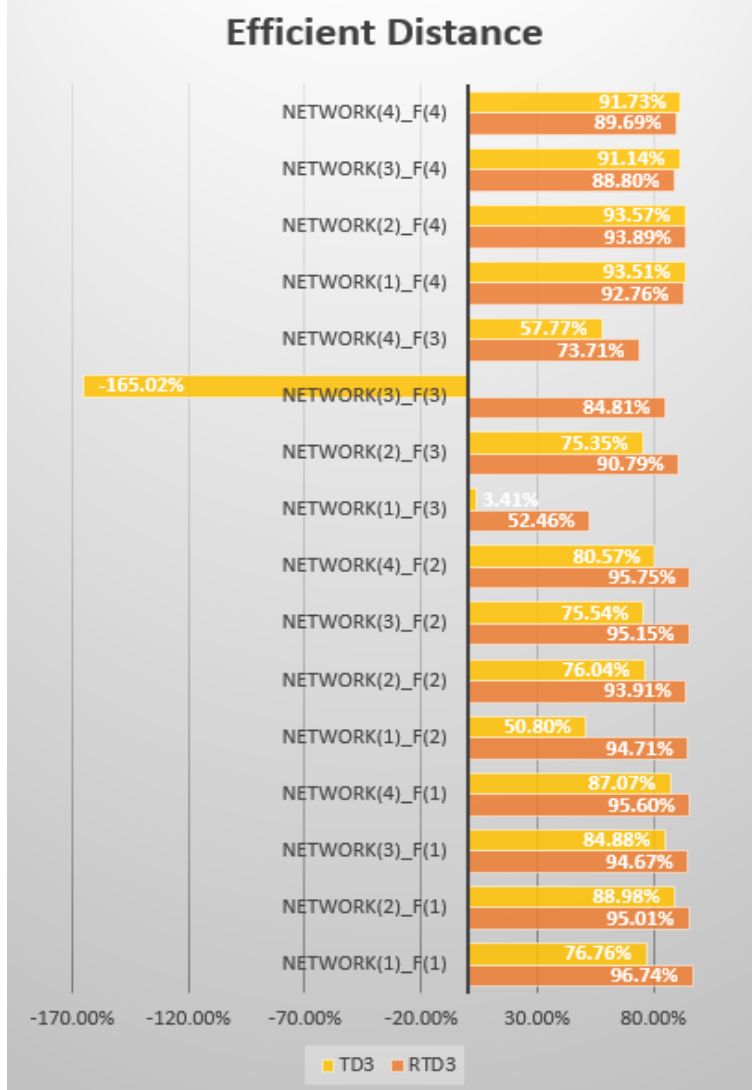
Figure 11. Under four reward function settings, the comparison of the average efficient distance of RTD3 and TD3 for four times of randomly initialized network node parameters when episode is in the range of 50,000 to 60,000.